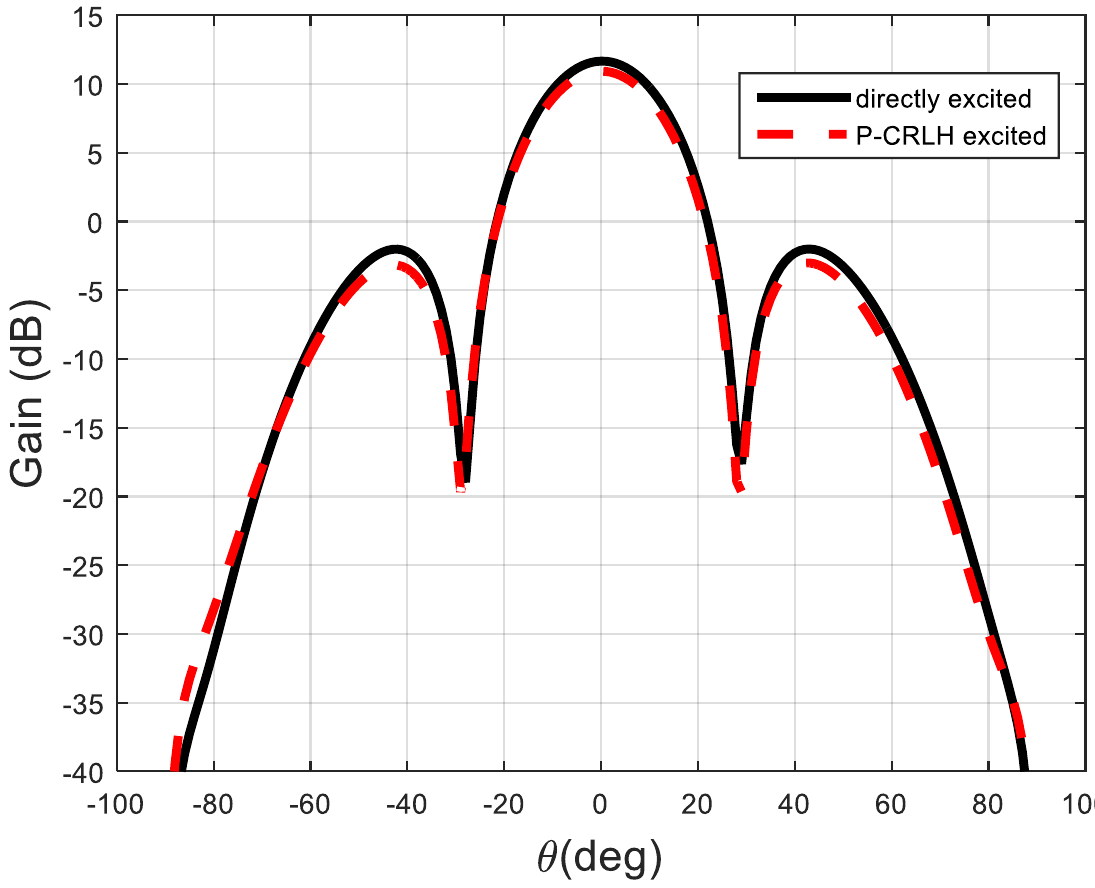
= 0 ° with directly excited and P-CRLH-excited Figure 10. Simulated main beam at broadside 𝜃 Figure 10. Simulated main beam at broadside θ 0 = 0 ◦ with directly excited and P-CRLH-excited 0 phases.